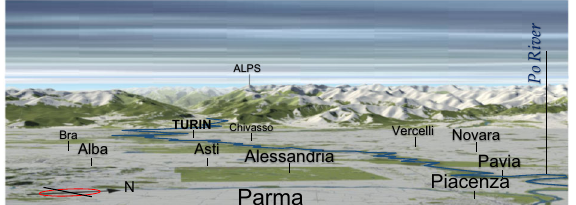
Fig. 1 Perspective of the Po River landscape ’ s hazard-exposed to the storms aggressiveness. Perspective of the Po River landscape ’ s hazard-exposed to the storms aggressiveness, which develops as a strip of territory inserted between Alps (to the north and west) and Apennine (to the south); the winding curve (in dark blue) is the Po River that within the town of Pavia and surrounded cities and villages goes up towards the town of Turin and thus the Alps (arranged from OpenStreet Map https://demo.f4map.com/#camera. theta = 0.9).